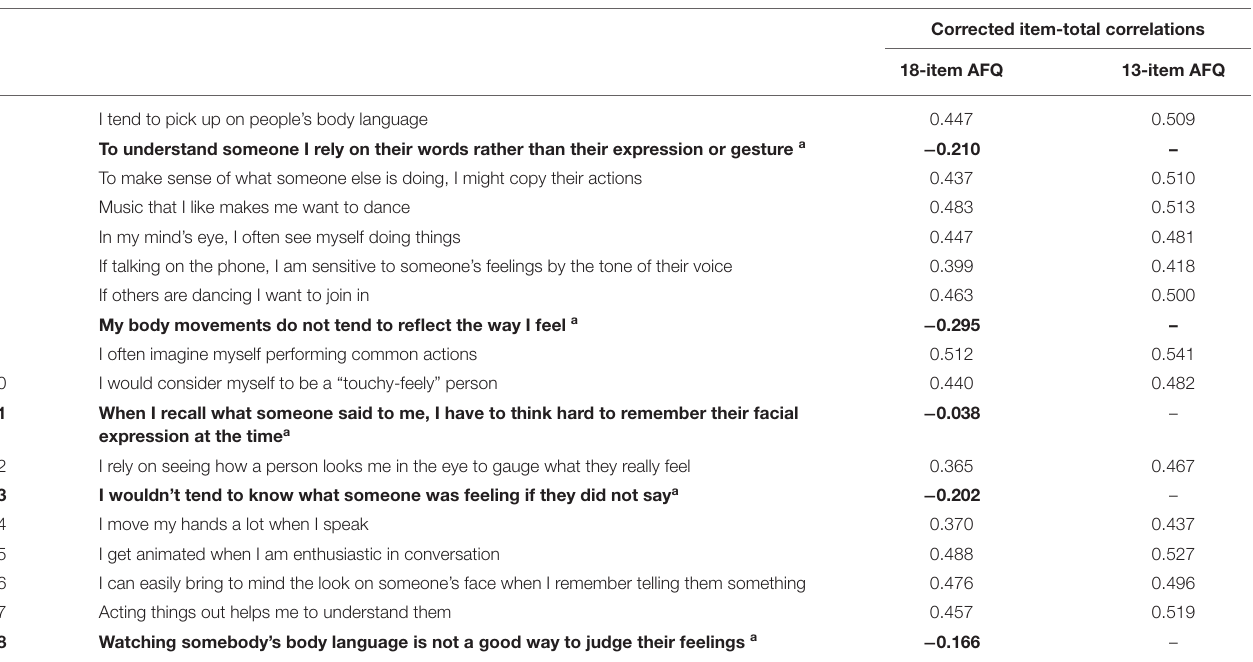
TABLE 1 | Item Total Correlations for the 18-item and 13-item